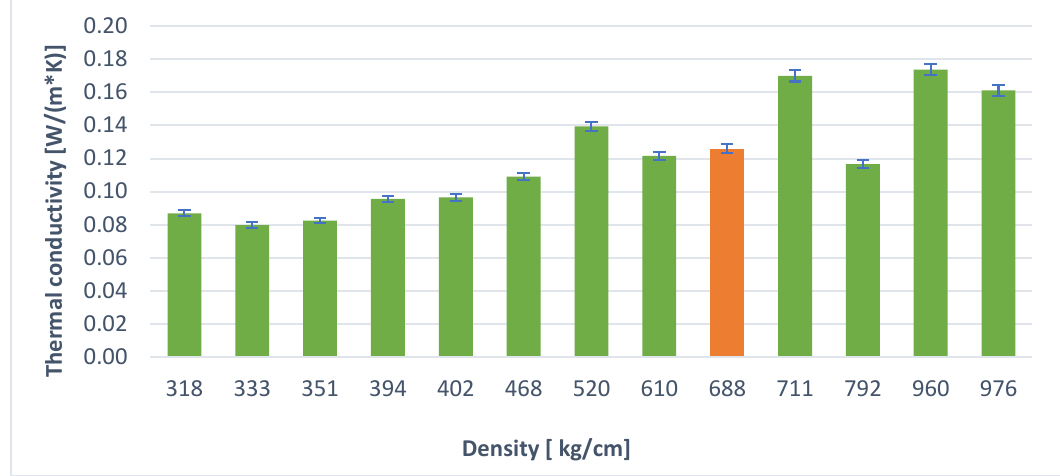
Figure 12. Relationship between thermal conductivity and density (samples with hydrogen peroxide).